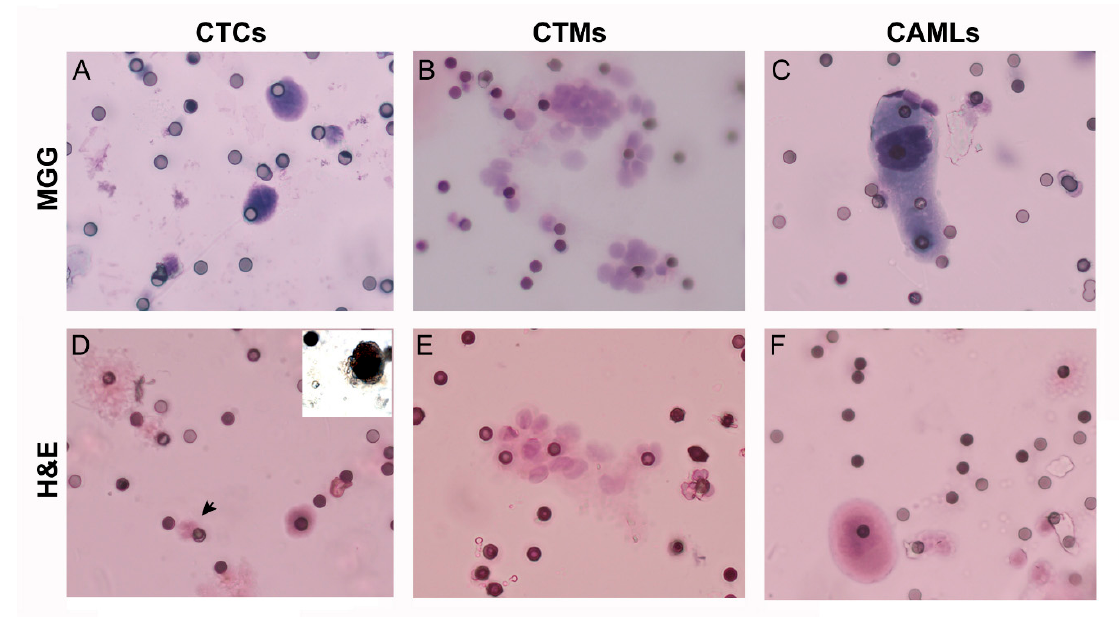
Figure 1. Representative staining with hematoxylin and eosin (H&E) and May–Grünwald–Giemsa (MGG) of circulating cells enriched by ScreenCell filters from blood samples of ACC patients. Circulating tumor cells (CTCs, A , D ), circulating tumor microemboli (CTMs, B , E ), and cancer associated macrophages (CAMLs, C , F ) were separated by ScreenCell devices from blood samples of ACC patients (magnification: 40 × ) and stained with hematoxylin and eosin (H&E) or May-Grünwald Giemsa (MGG). A polymorphonuclear leukocyte with the typical multilobated nuclei is indicated by the arrow ( D ) for comparison with a CTC. The small pores of 6 µ m are visible as small dots non homogenously distributed on the filter membrane. Inset in panel ( D ) shows the nuclear positivity to steroidogenic factor-1 (SF-1) antibody in a representative CTC obtained in a parallel filter from the same blood